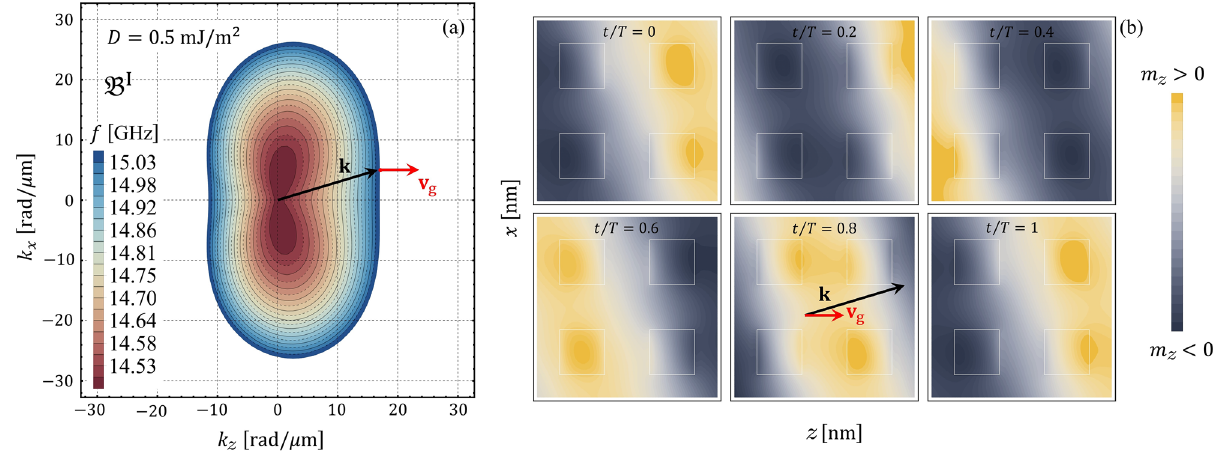
Figure 7. ( a ) Shows the isofrequency contour for the first band B I evaluated at D = 0.5 mJ/m 2 . In ( b ), the spatio-temporal dependence of the z -component of the magnetization, m z , is depicted. Here, m z is evaluated in arbitrary units and T is the period of the magnetization oscillations. The directions of the vectors k and v g are also shown in ( b ).